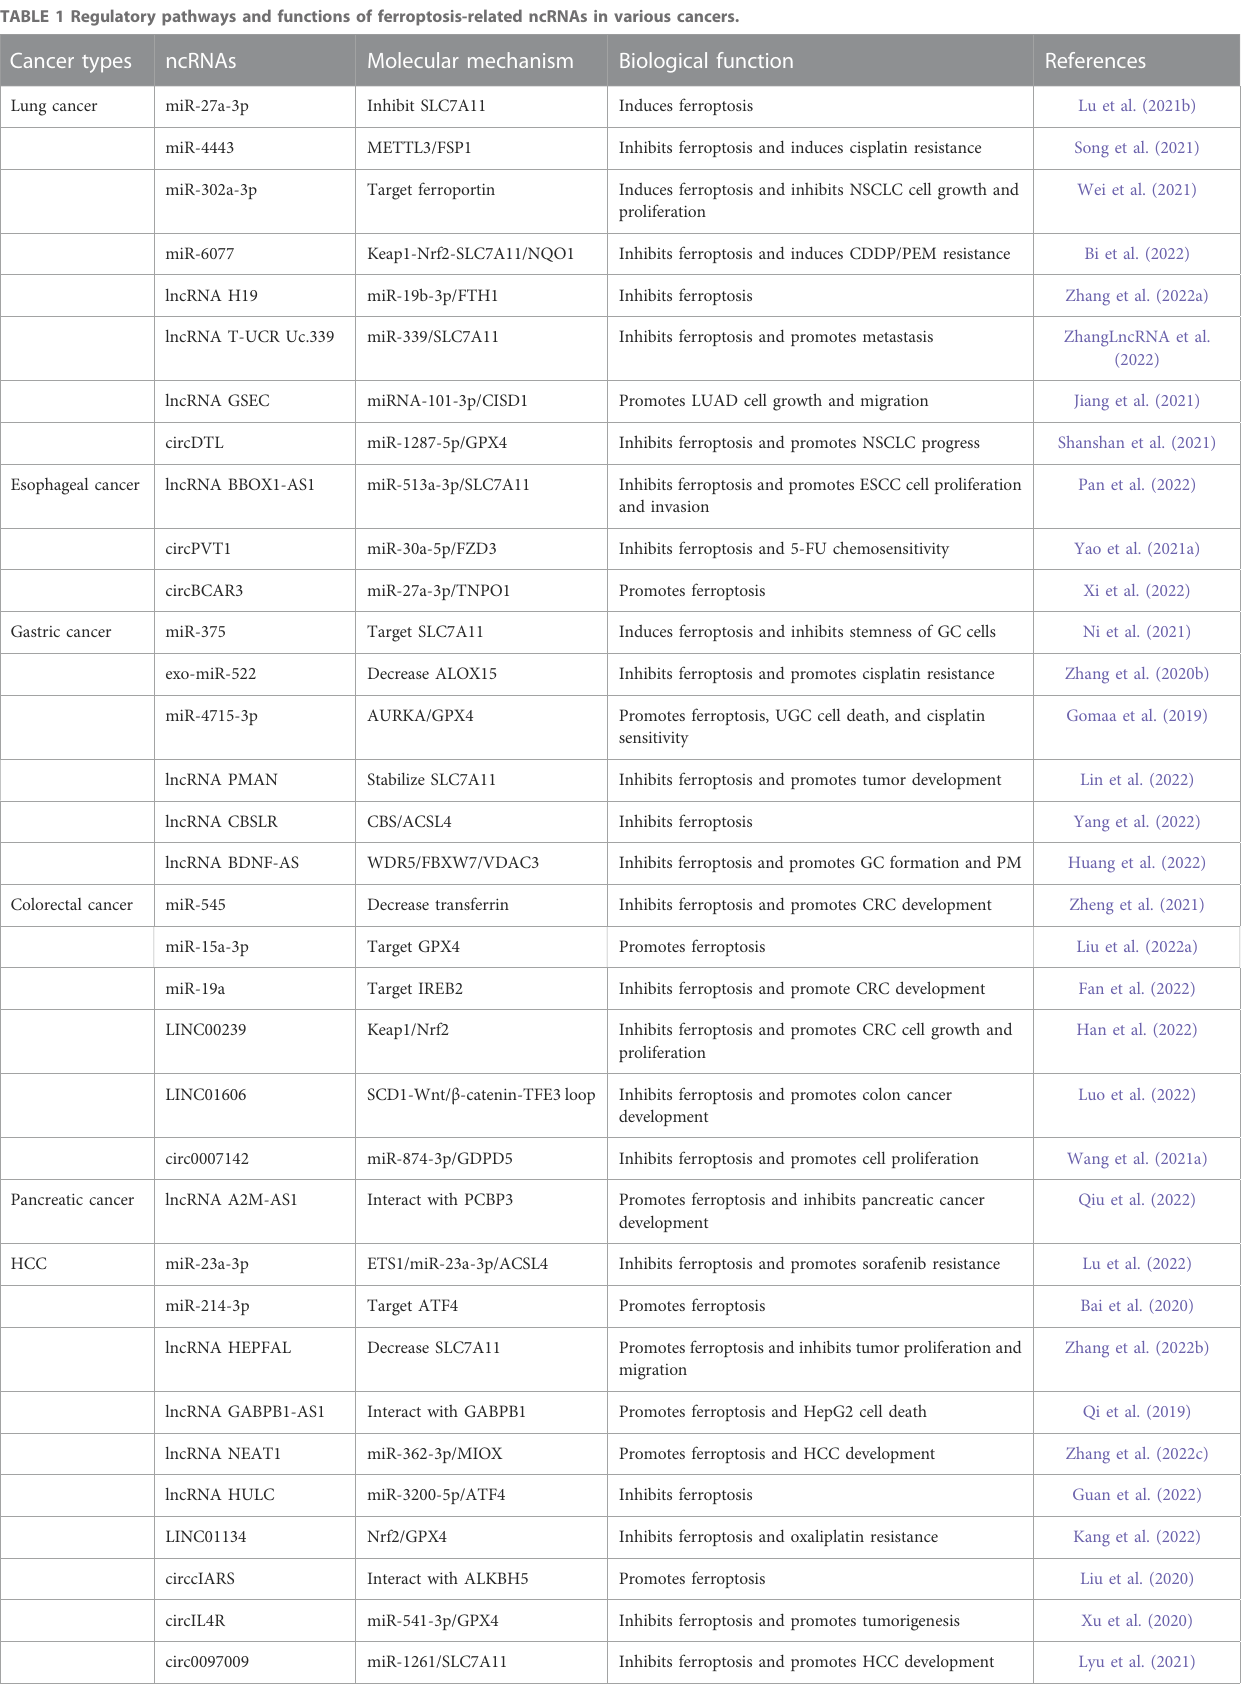
TABLE 1 Regulatory pathways and functions of ferroptosis-related ncRNAs in various